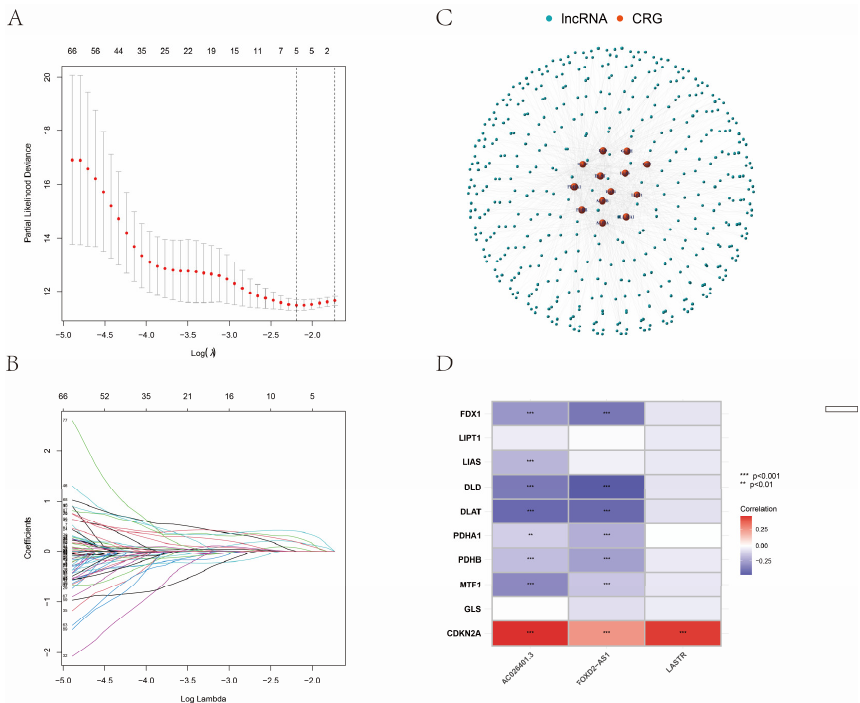
Figure 2. Identification of CRLRs. ( A ) The LASSO tuning parameters. ( B ) The CRLR LASSO coefficient profile. ( C ) Diagram of the coexpression network for cuproptosis genes and cuproptosis-related LncRNAs. ( D ) The heatmap for 10 cuproptosis genes with 3 cuproptosis-related LncRNAs. (** p < 0.01, *** p < 0.001).